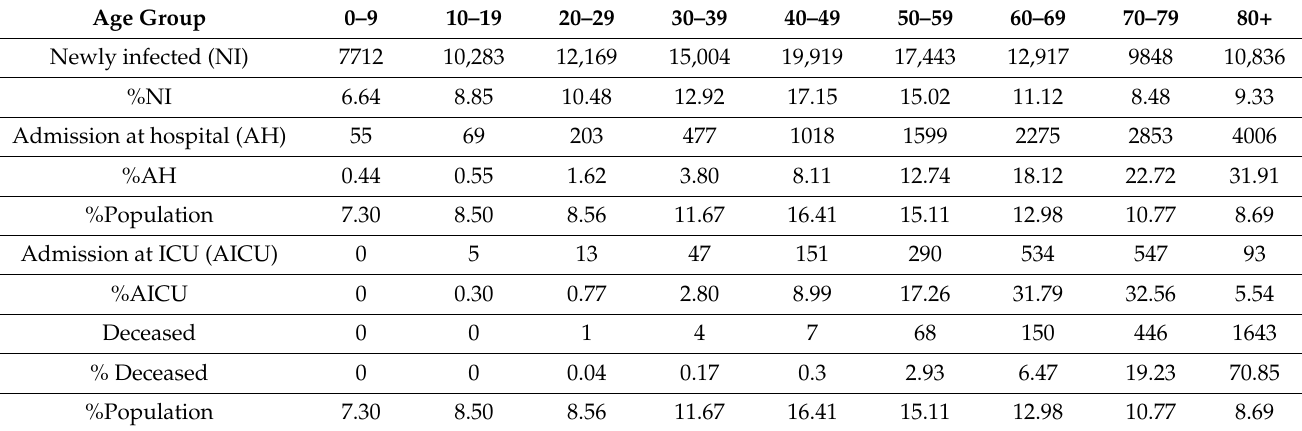
Table 3. Data corresponding to the full year—4 March 2020 to 1 April 2021.